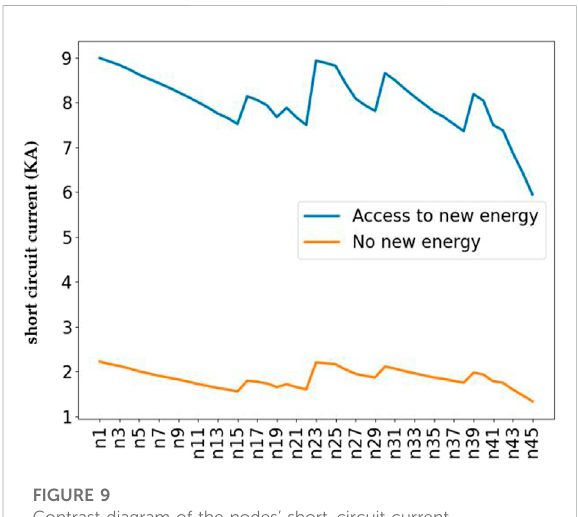
FIGURE 9 Contrast diagram of the nodes ’ short-circuit